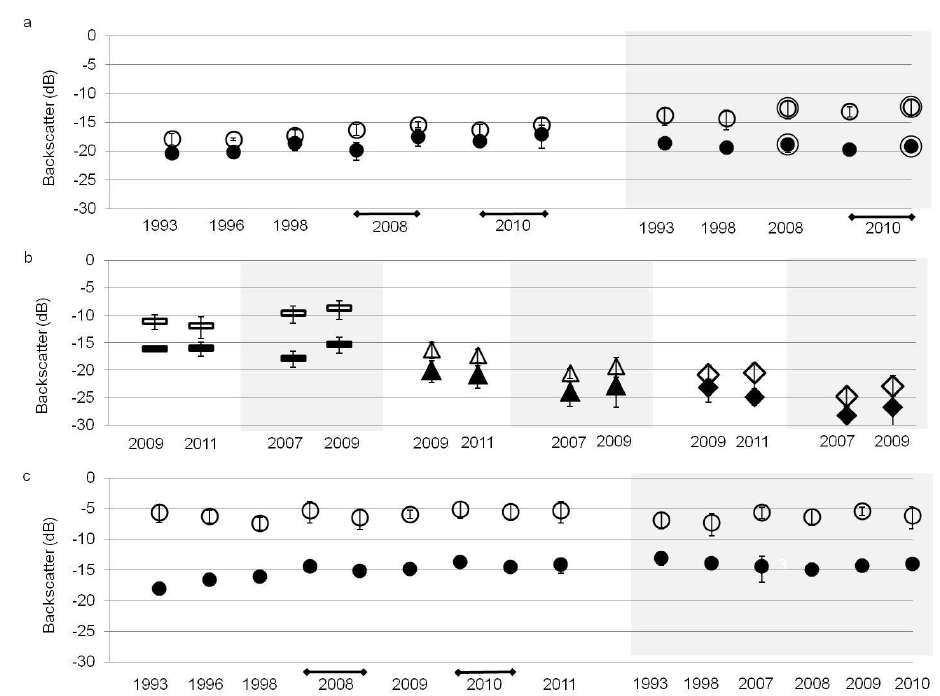
Fig. 4. Mean SAR intensity backscatter values in decibels from floating lake ice (open symbols) and grounded lake ice (closed symbols) from (a) L-band HH from JERS-1 and PALSAR, (b) L-band quad-pol from PALSAR coherency matrix elements T 11 (rectangles), T 22 (triangles) and T 33 (diamonds) that indicate double-bounce, volumetric scattering, and roughness, respectively, (c) C-band VV from ERS-1 and ERS-2. Incidence angles are (a) 39–40 degrees except 24 degrees as noted by concentric circles, (b) 23 degrees, and (c) 24 degrees. Shaded areas highlight lake ice from the northern Seward Peninsula (NSP) and white areas highlight lake ice from the Alaska Arctic Coastal Plain (ACP). Mean backscatter values are from spring lake ice (late March–April) from study lakes outlined in Fig. 1. Error bars represent standard